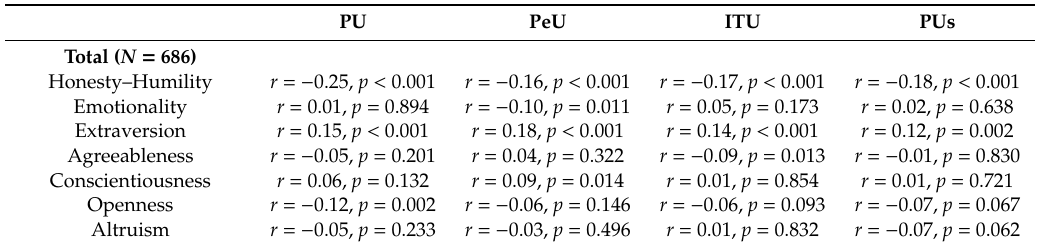
Table 2. Partial Pearson correlations between the HEXACO-PI-R and technology acceptance model (TAM) scales. PU PeU ITU PUs Total ( N = 686) Honesty–Humility r = − 0.25, p < 0.001 r = − 0.16, p < 0.001 r = − 0.17, p < 0.001 r = − 0.18, p < 0.001 Emotionality r = 0.01, p = 0.894 r = − 0.10, p = 0.011 r = 0.05, p = 0.173 r = 0.02, p = 0.638 Extraversion r = 0.15, p < 0.001 r = 0.18, p < 0.001 r = 0.14, p < 0.001 r = 0.12, p = 0.002 Agreeableness r = − 0.05, p = 0.201 r = 0.04, p = 0.322 r = − 0.09, p = 0.013 r = − 0.01, p = 0.830 Conscientiousness r = 0.06, p = 0.132 r = 0.09, p = 0.014 r = 0.01, p = 0.854 r = 0.01, p = 0.721 Openness r = − 0.12, p = 0.002 r = − 0.06, p = 0.146 r = − 0.06, p = 0.093 r = − 0.07, p = 0.067 Altruism r = − 0.05, p = 0.233 r = − 0.03, p = 0.496 r = 0.01, p = 0.832 r = − 0.07, p =